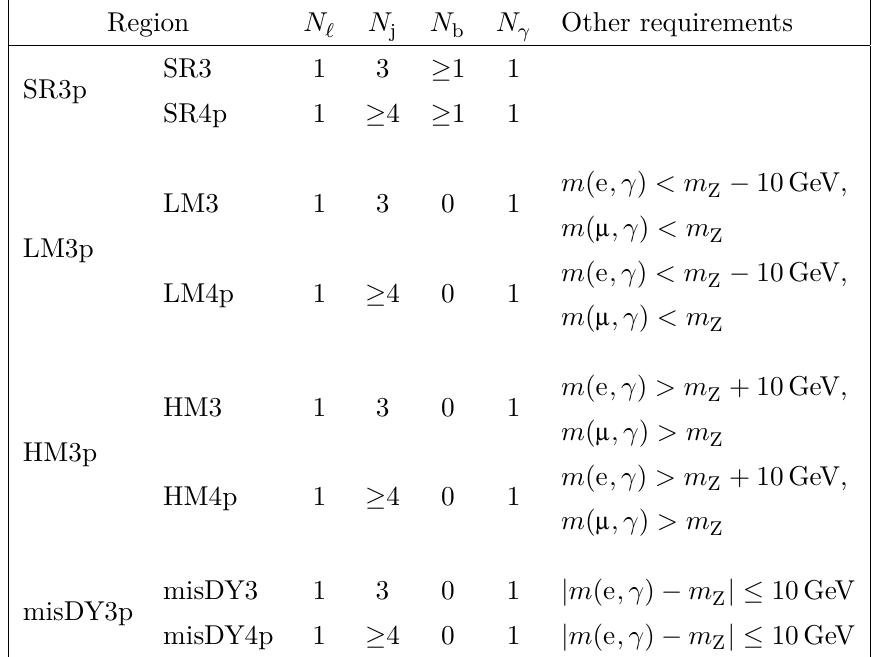
Table 3 . Overview of signal and control